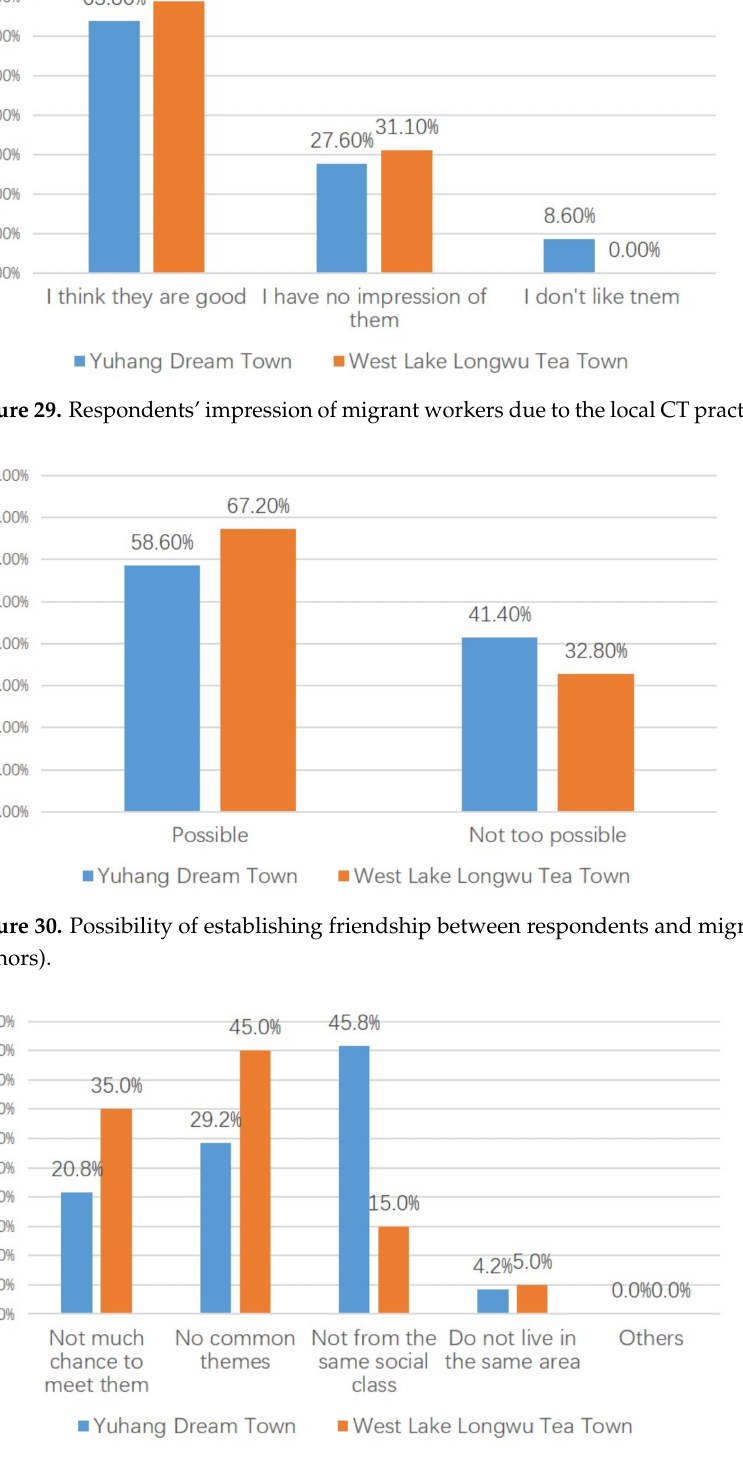
Figure 31. Reasons why respondents thought they are unable to form friendships with migrant workers (source: